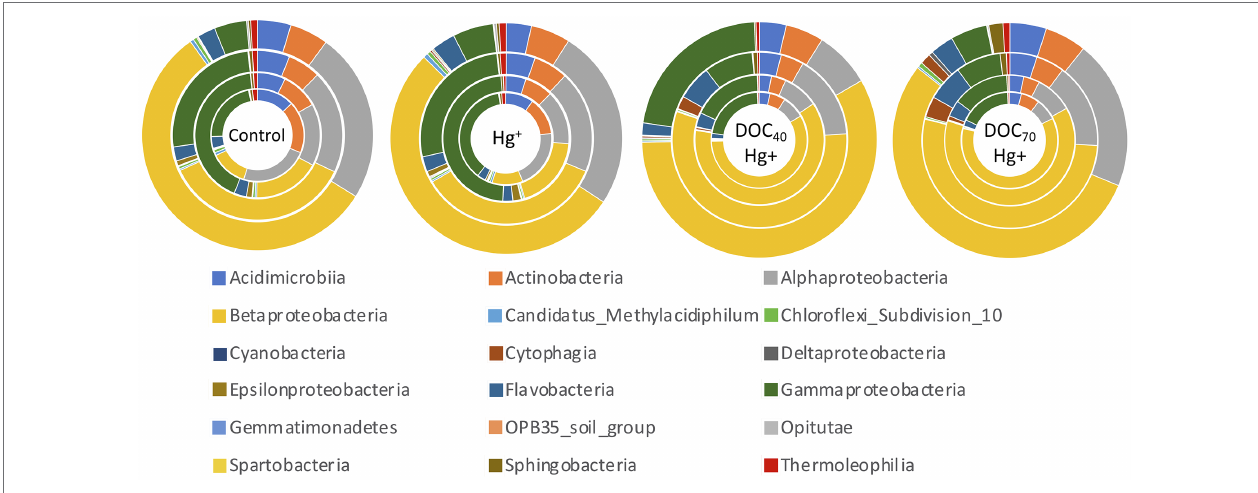
FIGURE 5 | Relative abundance (%) of bacterial classes. Sampling days are represented by rings ordered from inside out: day 3–day 12.